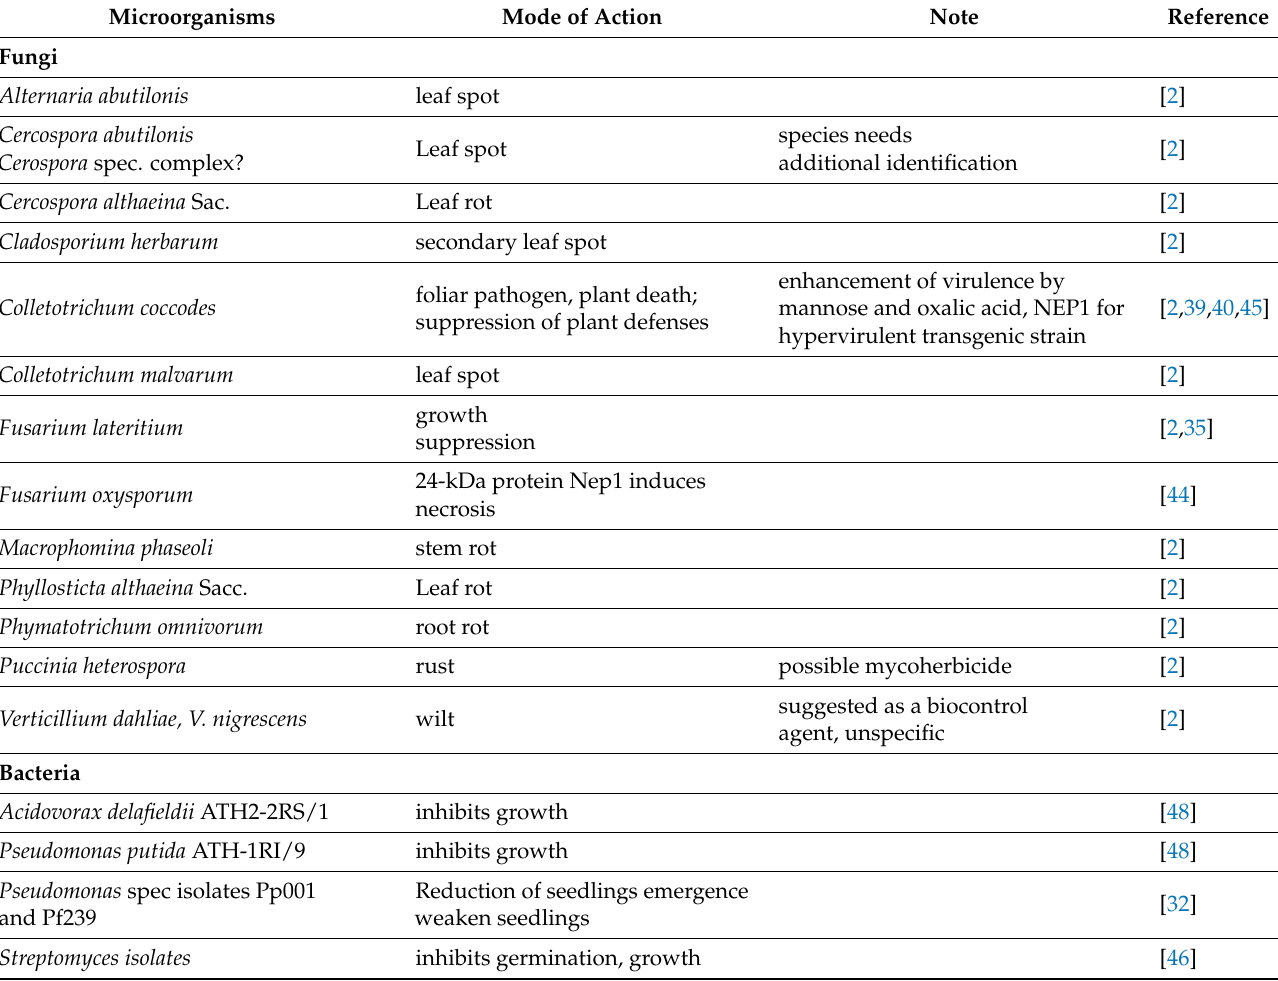
Table 1. Microorganisms with biocidal effects on